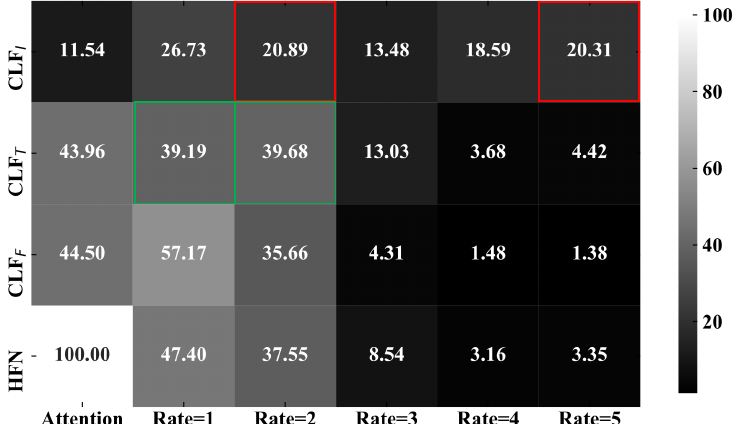
Figure 6. A neural network is trained to measure the importance of classifiers and the final decision is determined by adaptive attention weighted based on prediction results of CLF F , CLF T , and CLF I . Decision diversity has guaranteed the generalization and robustness of the whole